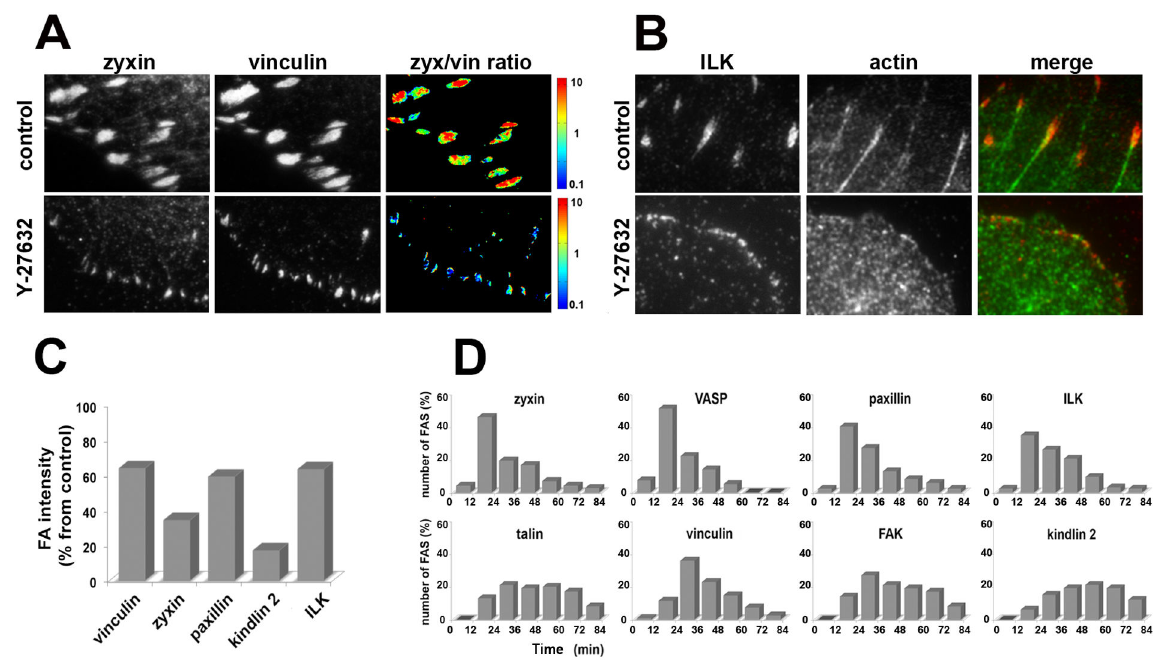
Figure 5. Peripheral FAs in Y-27632 treated cells differ from control FAs in molecular composition and lifespan. ( A ) Comparison of zyxin and vinculin fluorescence intensity for FAs in untreated cells, and peripheral FAs in Y-27632 treated cells. Cells prior to and following 60 min of Y-27632 treatment were double-labeled for zyxin (left) and vinculin (center). Right : The fluorescence ratio image (zyxin/vinculin) in a logarithmic, blue-to-red spectrum scale, representing the ratio value. ( B ) Comparison of ILK and actin localization in FAs of untreated cells, and in peripheral FAs of Y-27632 treated cells. Two-color TIRF microscopy of the cells prior to and following 60 min of Y-27632 treatment was used to assess for ILK (left) and actin staining (center). Right : A merged image (ILK in red and actin in green), demonstrating enrichment of actin in the FA sites. ( C ) Normalized vinculin, zyxin, paxillin, kindlin-2 and ILK fluorescence intensities in peripheral FAs following 60 min of Y-27632 treatment, expressed as a percentage of intensity of the same protein in FAs of untreated cells. Fluorescence intensity measurements were averaged over 150 individual FAs. ( D ) Lifespan of peripheral FAs for each protein, expressed as the percentage of total FA number over time, averaged over 150 individual FAs for each